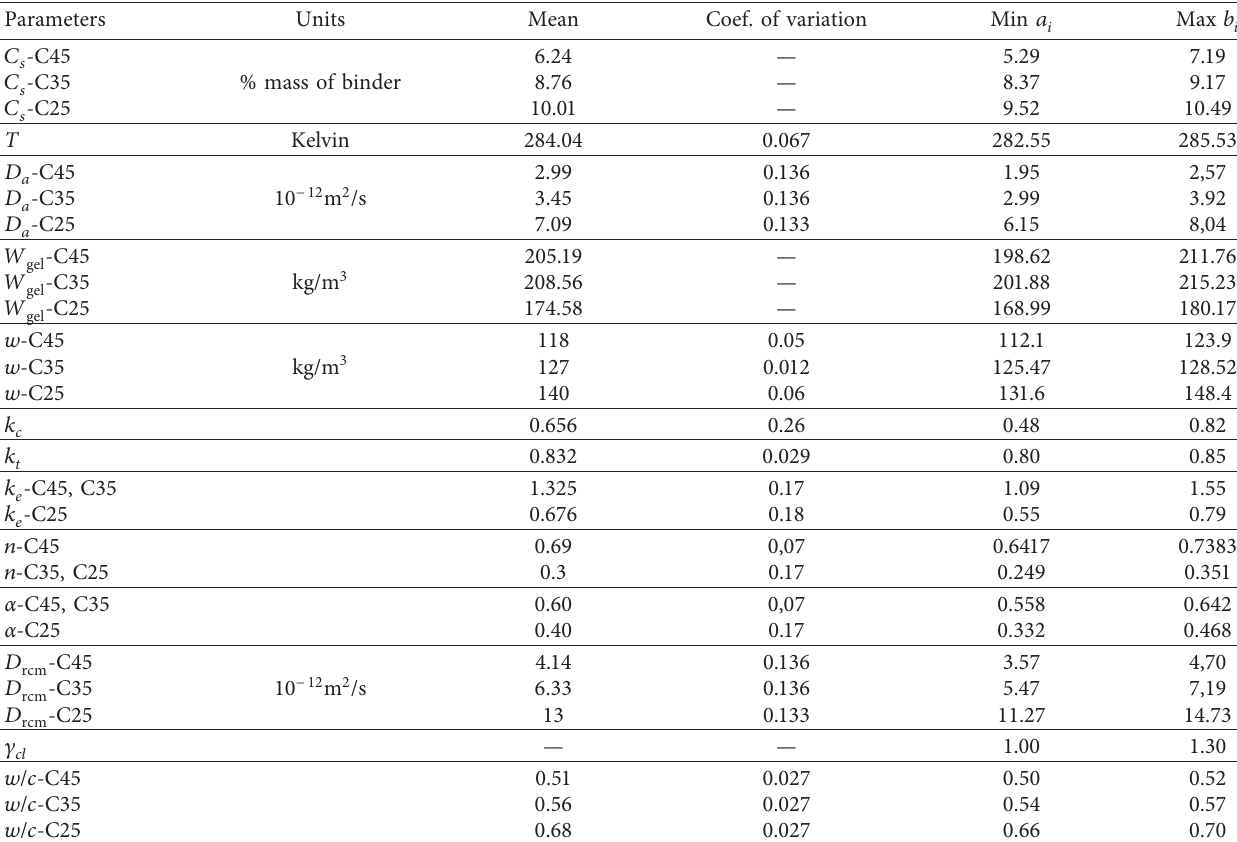
Table 8: Values of input parameters for chloride ingress models by Rakotovao Ravahatra et al. [17].